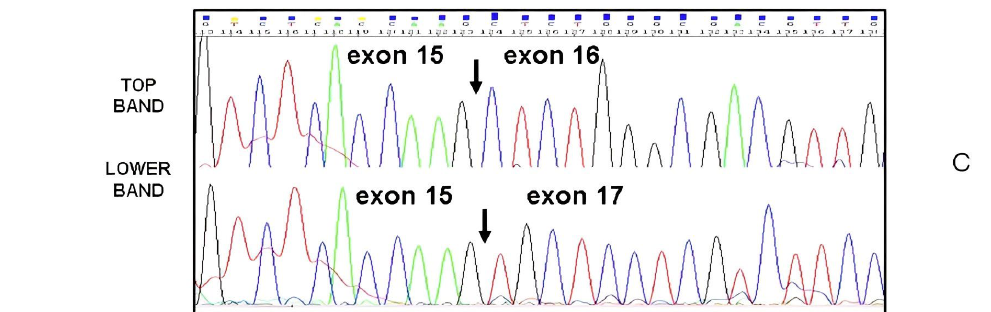
Figure 3. ( A ). Amplification of cDNA fragments from patients with (1,2,3,6) and without (4,5,7,8,9) and the LDLR intron 16 + 4 (c.2389+4 A>G) variant. The cDNA from leukocytes of heterozygous carriers showed two bands of the normal size (exon 16 present) and a shorter band that corresponded to the fragment lacking exon 16. ( B ). Sanger sequence (reverse strand) of PCR fragments from patients with (above sequence) and without (below sequence) the intron 16 variant. The amplification of the fragment without exon 16 resulted in two peaks with overlapping exon 16 and exon 15 sequences. ( C ) The top and lower bands from patients were excised from the agarose gels and sequenced, showing the normal exon 15–16 and alternative exon 15–17 sequences.